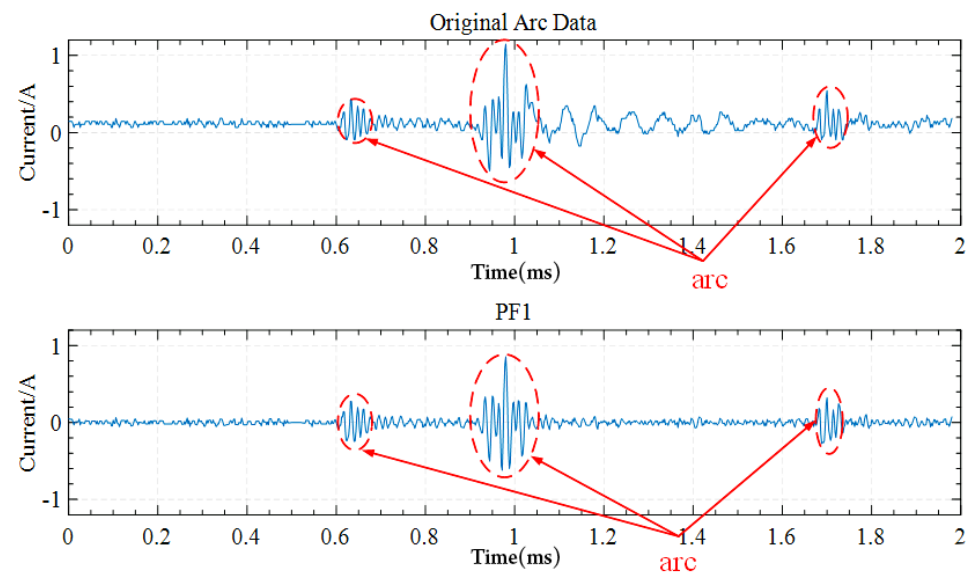
Figure 12. The waveforms of the original sampled data and its PF 1 .